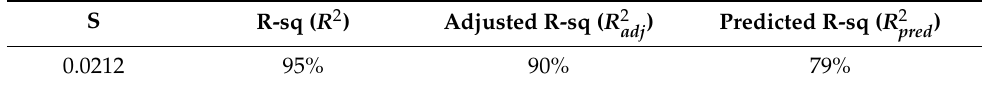
Table 2. Model summary of the first